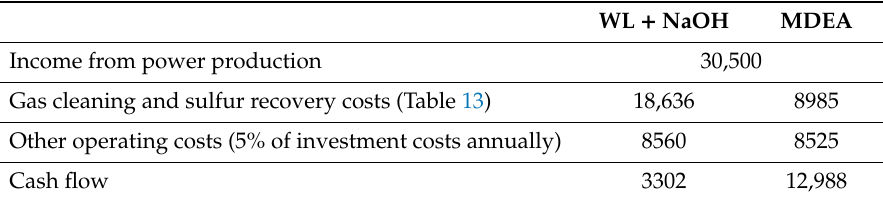
Table 15. Cash flow estimation (in thousands USD / year) for the whole plant.